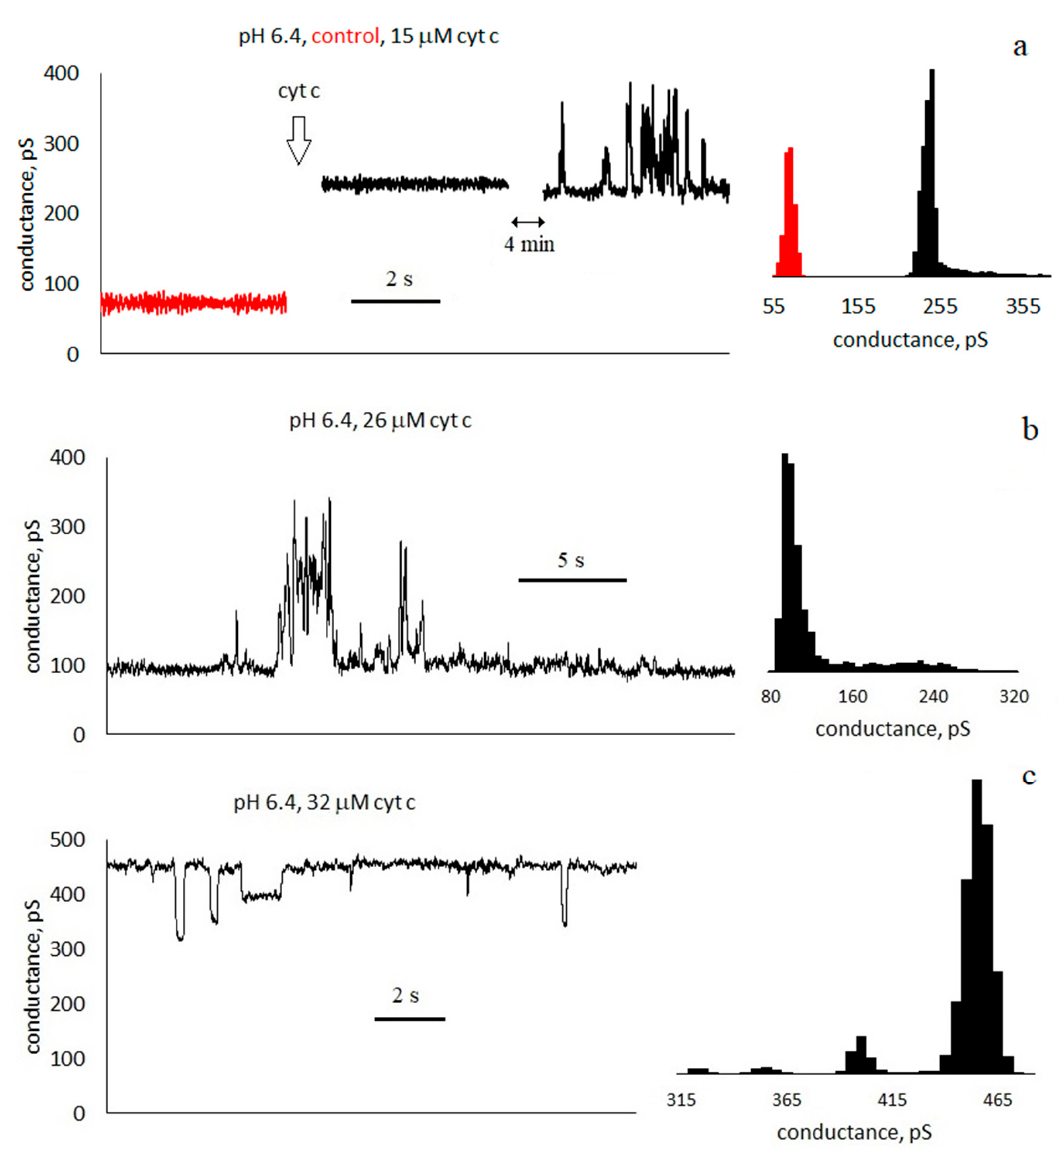
Figure 2. Conductance traces and histograms of asolectin membranes with symmetrical addition of cyt c at pH 6.4: ( a ) control (red) and conductance after addition of 15 µM cyt c, ( b ) 26 µM, and ( c ) 32 µM; 0.1 M KCl, 20 ms averaging.